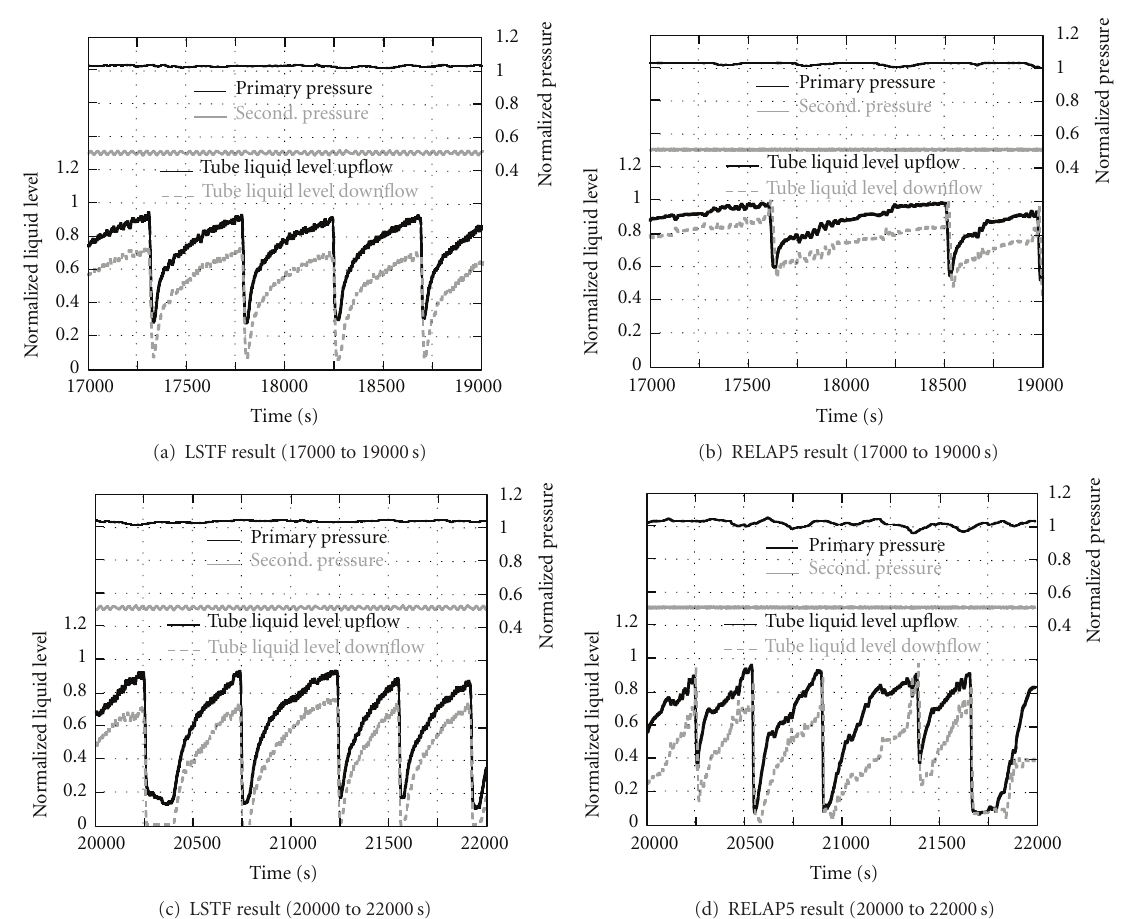
Figure 18: LSTF and RELAP5 results for collapsed liquid levels in SG Tube 3 in loop with PZR compared with primary and secondary pressures during large-amplitude level oscillation